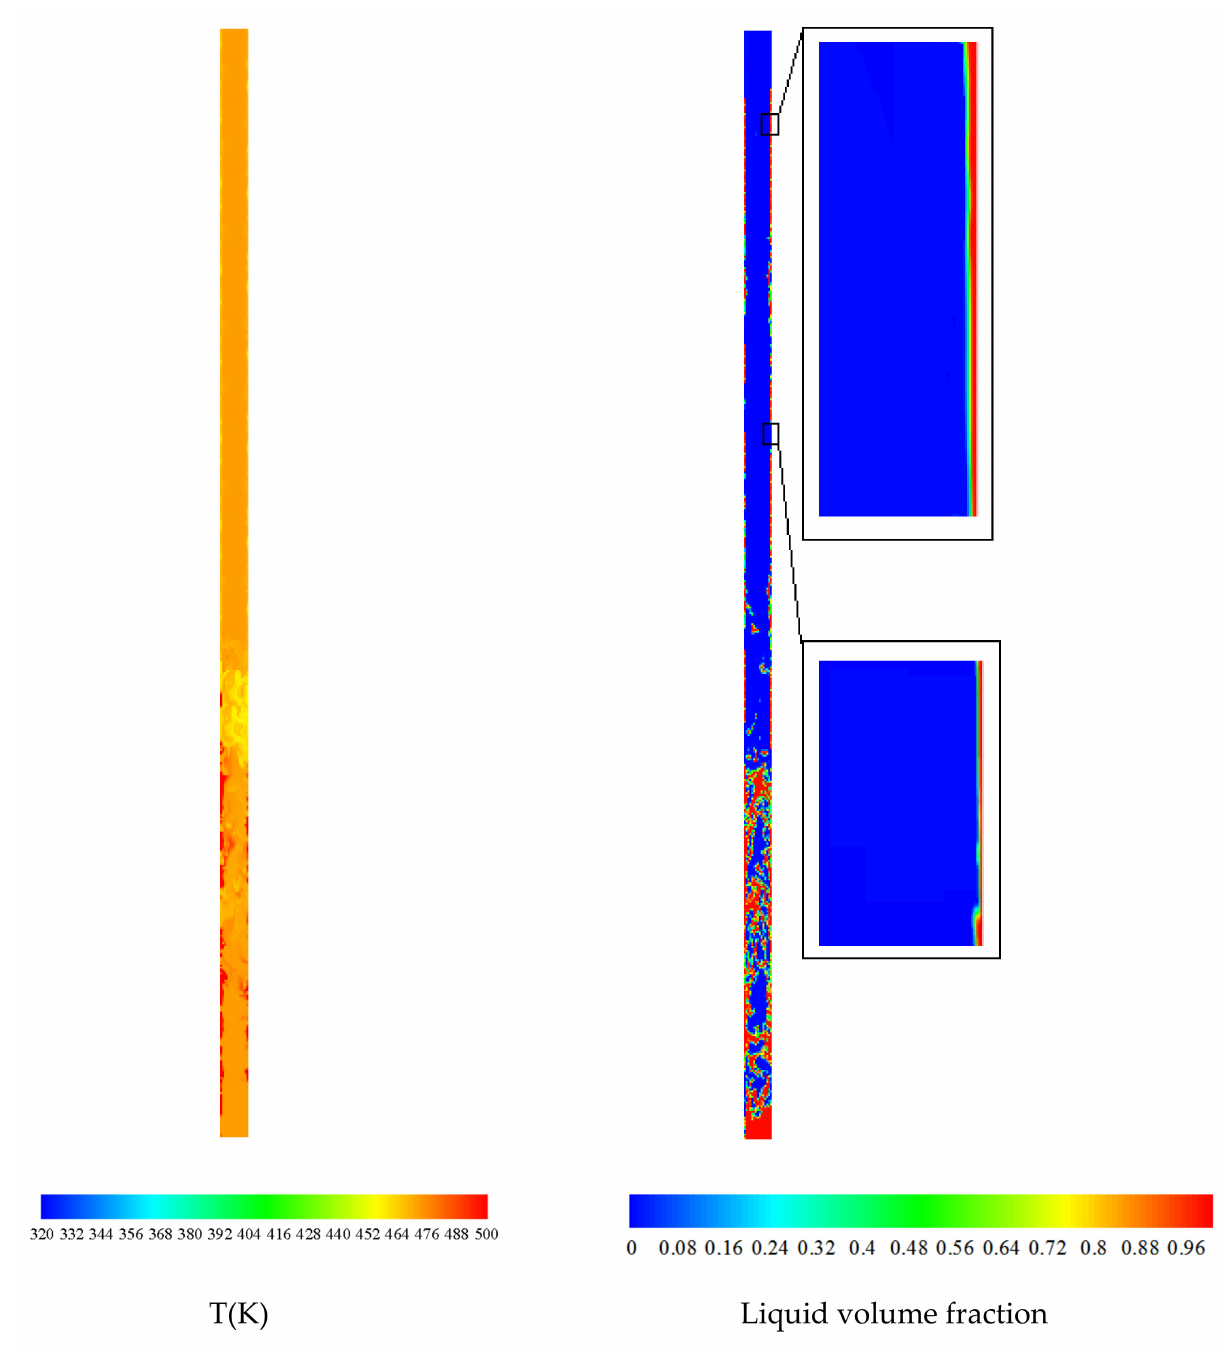
Figure 11. Steady state (84 s) liquid volume fraction contours and the static temperature distribution for FR =